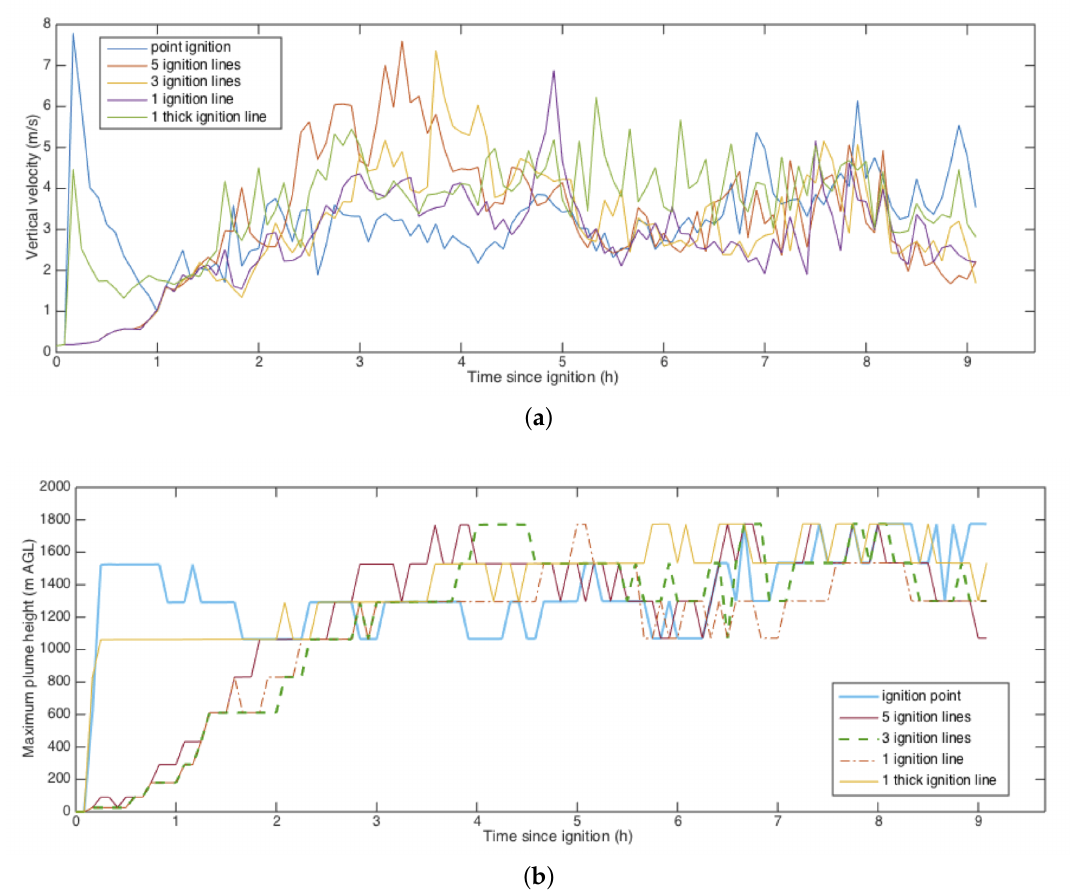
Figure 11. Results from numerical simulations for Fort Stewart (02/14/2013) with different ignition procedures. ( a ) Time series of the simulated maximum fire-induced updraft; ( b ) Same for plume top